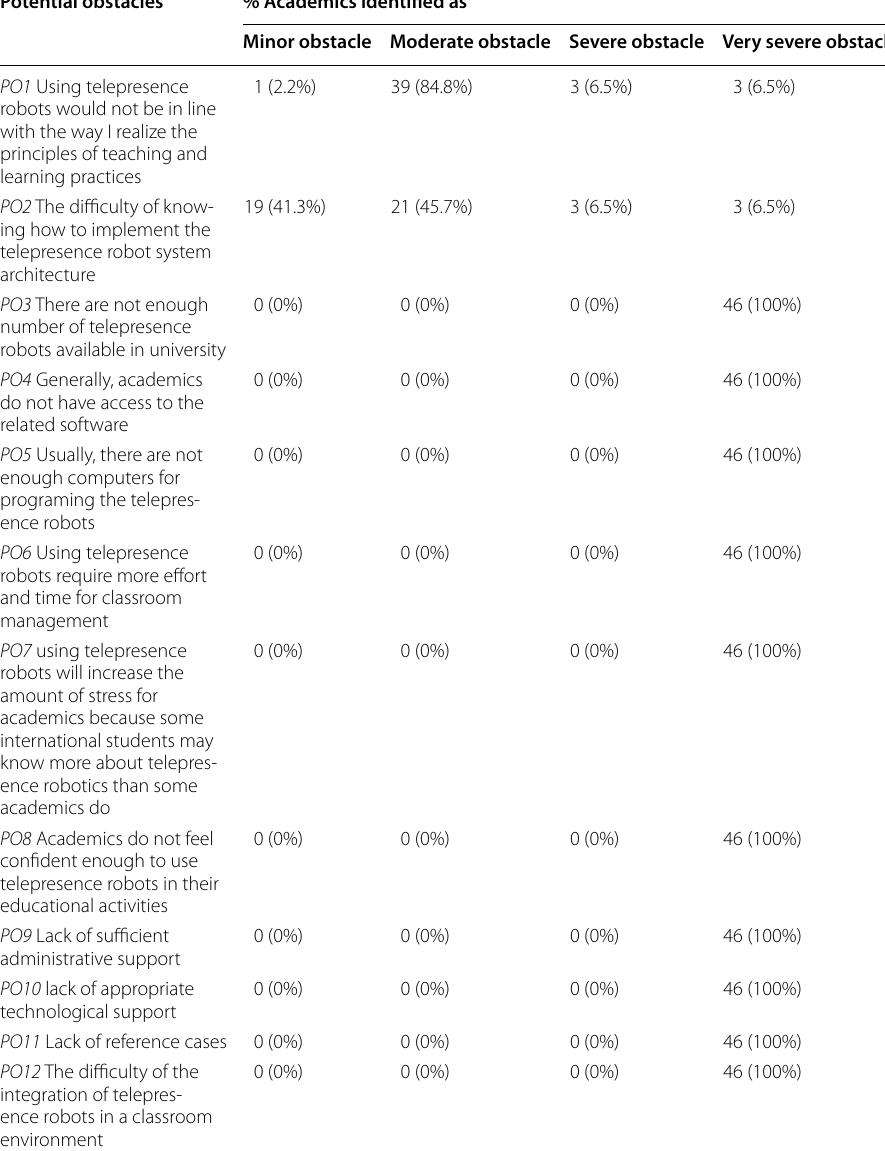
Table 9 Potential obstacles that may hinder academics from using telepresence robots Potential obstacles % Academics identified